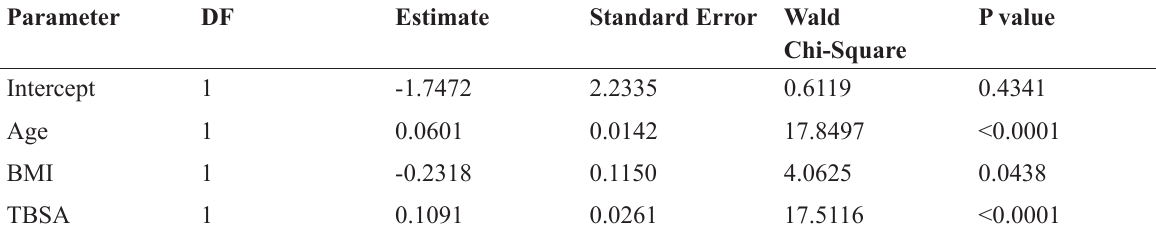
Table 2. Analysis of maximum likelihood estimates of burn mortality Parameter